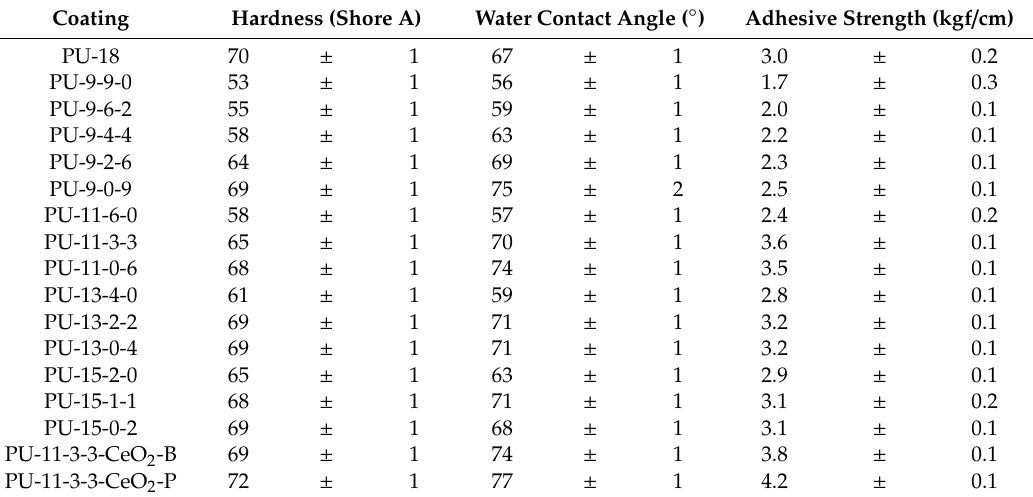
Figure 2. XPS spectra ( 1 ) and SEM ( 2 ) of PU-11-3-3-CeO 2 -P coating (insight dispersion). Table 2. Protective properties of